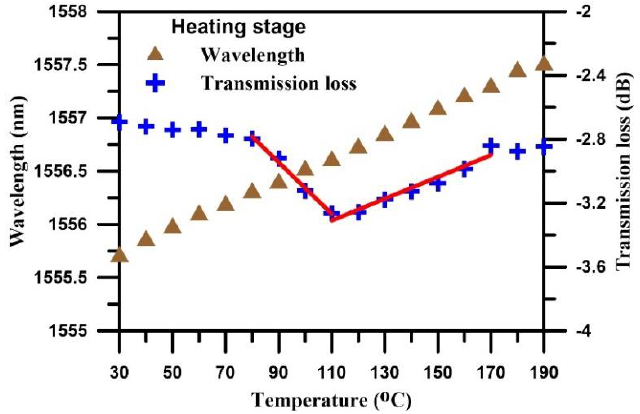
Figure 9. Temperature dependence of wavelength and transmission loss when heating stage.